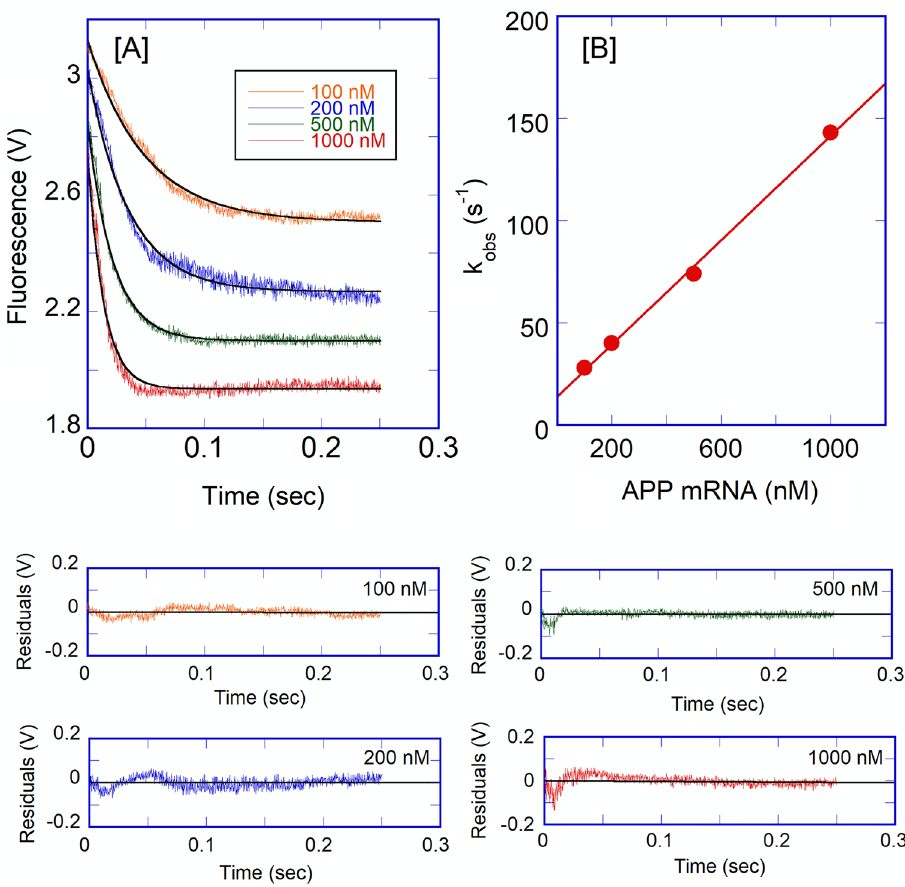
Figure 8. Kinetic rates for the binding of APP IREmRNA to IRP1 protein in the presence of iron. ( A ) Kinetic trace for the binding of IRP1 (0.1 μM final) at varying concentration of APP mRNA (0.1, 0.2, 0.5, and 1 μM final) in the presence of 50 μM Fe 2+ . ( B ) The observed rate constant for the binding of IRP1 with APP mRNA in the presence of iron was plotted as a function of increasing concentrations of APP mRNA. Data points in the plots of k obs versus APP mRNA concentration were obtained from the three independent experiments, and the average value of the experimental data was reported. The solid line represents the fitted curve for a single exponential function. Residuals for the corresponding fits are shown in the lower